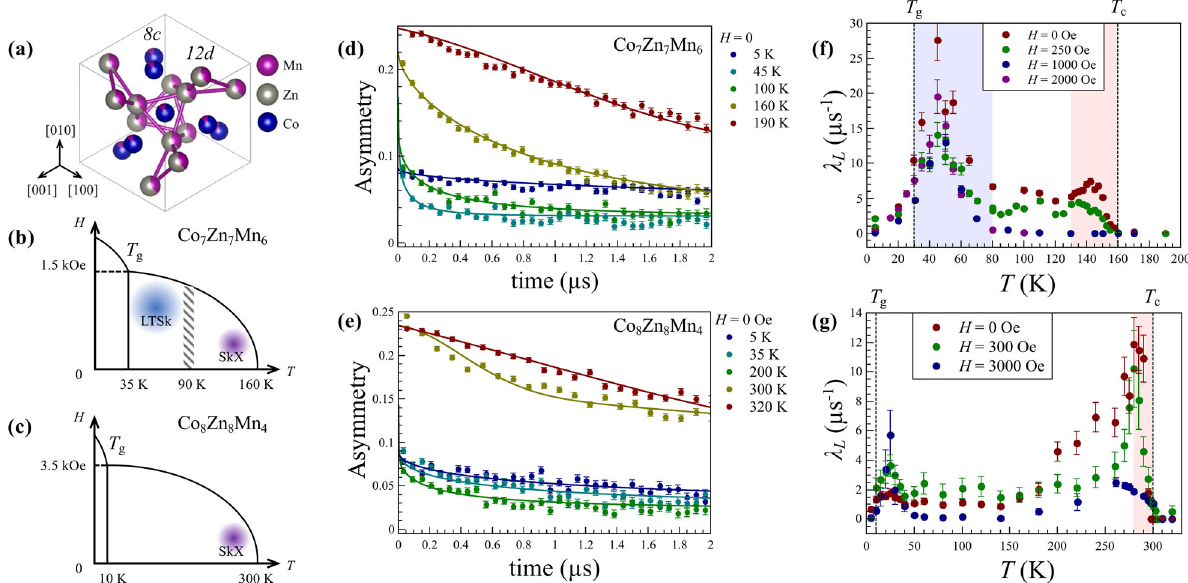
Fig. 1 Crystal structure, magnetic phase diagrams and muon spectroscopy of CoZnMn alloys. a β -Mn-type structure (space group: P 4 1 32), comprising 8 c and 12 d atomic sites, as viewed along the [111] axis. The bonds between Mn atoms at 12 d sites are shown. Schematic T − H magnetic phase diagram in ( b ) Co 7 Zn 7 Mn 6 and ( c ) Co 8 Zn 8 Mn 4 obtained from SANS and susceptibility measurements 13,15 . Measured (symbols) and fi tted (solid lines) μ SR spectra at selected temperatures for Co 7 Zn 7 Mn 6 ( d ) and Co 8 Zn 8 Mn 4 ( e ). Corresponding temperature dependencies of relaxation rates λ ( T ) obtained from the fi ts are shown in ( f ) and ( g ) for Co 7 Zn 7 Mn 6 and Co 8 Zn 8 Mn 4 , respectively. The temperature ranges for SkL and LTSk phases are indicated by purple and blue background colours, respectively. In ( d , e ), error bars indicate the statistical error. In ( f , g ), error bars are obtained from the fi tted model described in the main